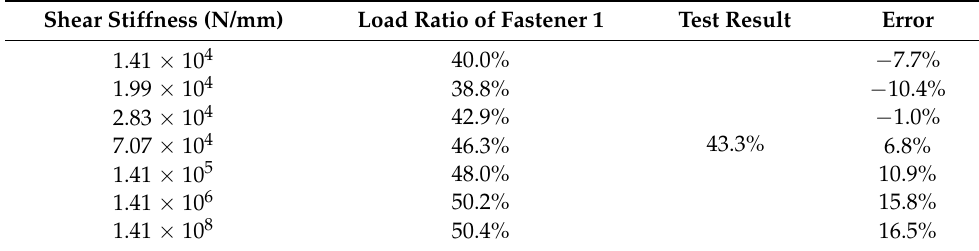
Table 2. The pin-load distribution ratio for different values of the fastener stiffness.